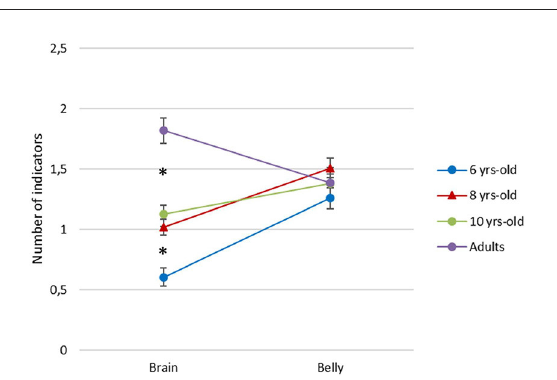
FIGURE3 Mean number of graphic indicators as a function of age and drawing